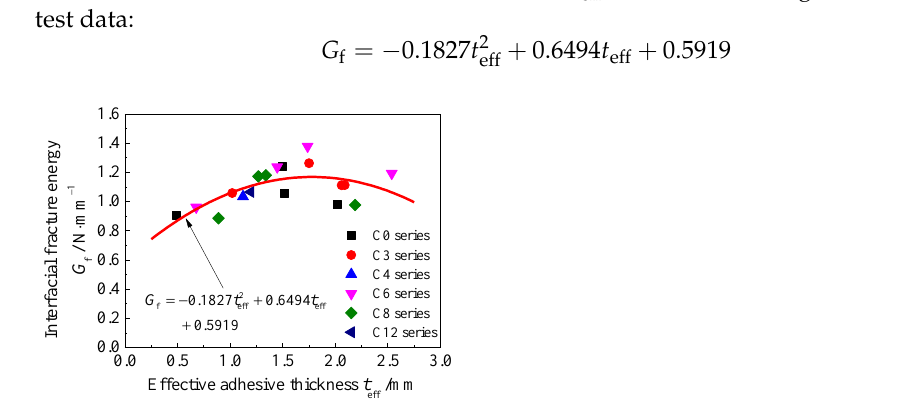
t . Figure 12. Interfacial fracture energy G eff